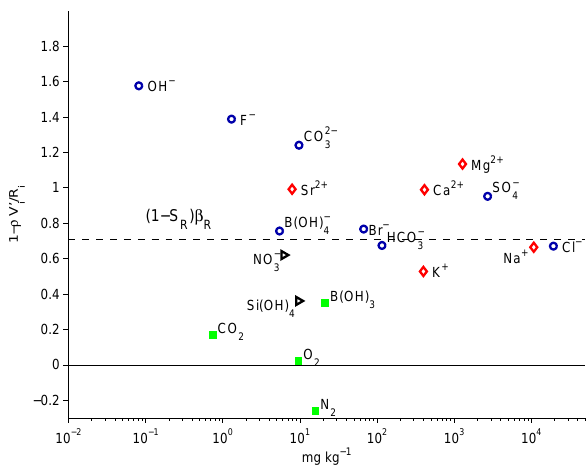
0 i /M i in Eq. (28) for seawater at